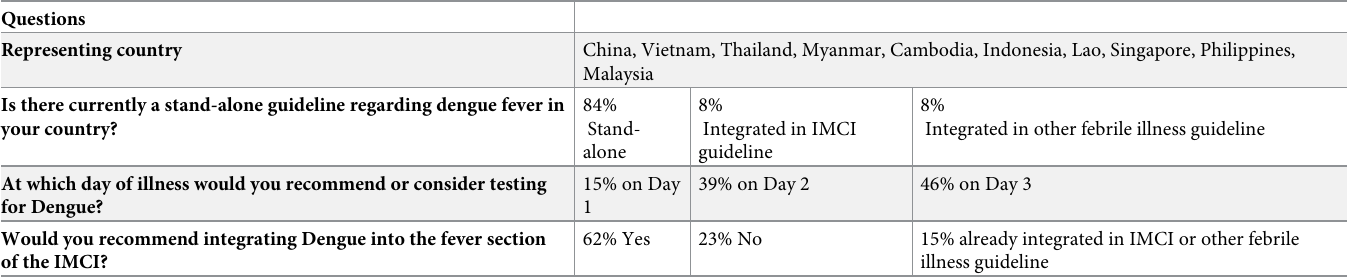
Table 3. Summary of results from a survey of experts on dengue algorithms.